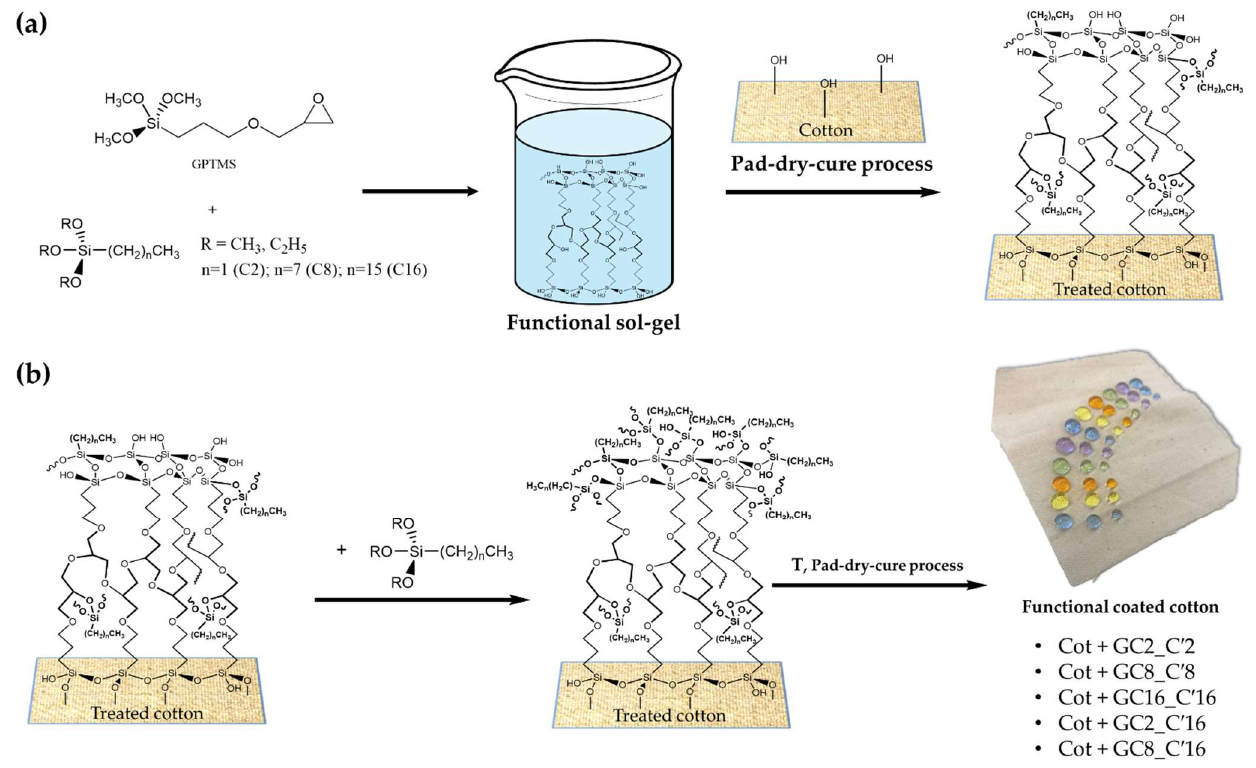
Figure 6. Two-step synthetic pathways for the development of the final functional coated cotton fabrics involving the condensation reaction between the cotton cellulose and alkoxysilane ends ( a ), and subsequent anchorage of alkyl(trialkoxy)silanes ( b ).